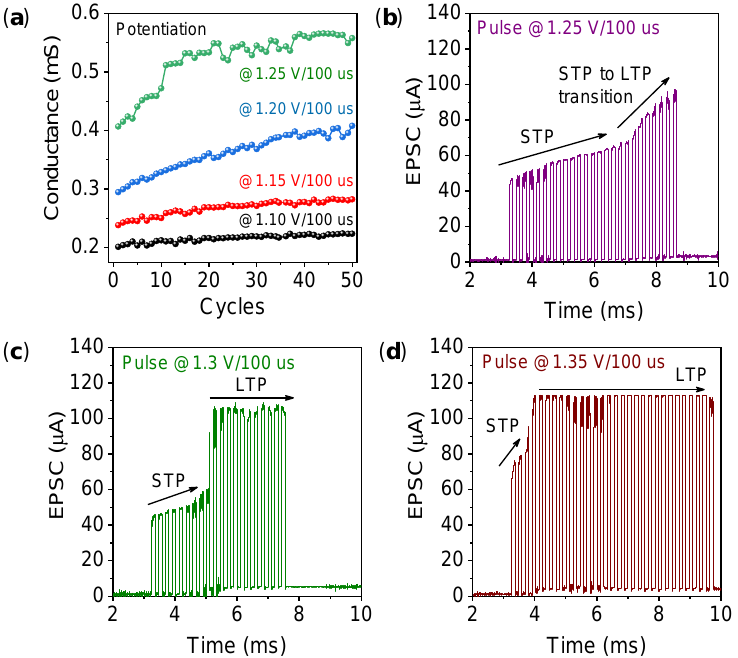
Figure 3. ( a ) Potentiation behavior under an identical pulse sequence of amplitude 1.1 V/100 µs to 1.25 V/100 µs. ( b – d ) EPSC obtained in the TO/WO x /TaO x /TiN memristor during the transition from STP to LTP was observed by increasing the pulse amplitude and number from 1.1 V/100 µs to 1.25 V/100 µs.